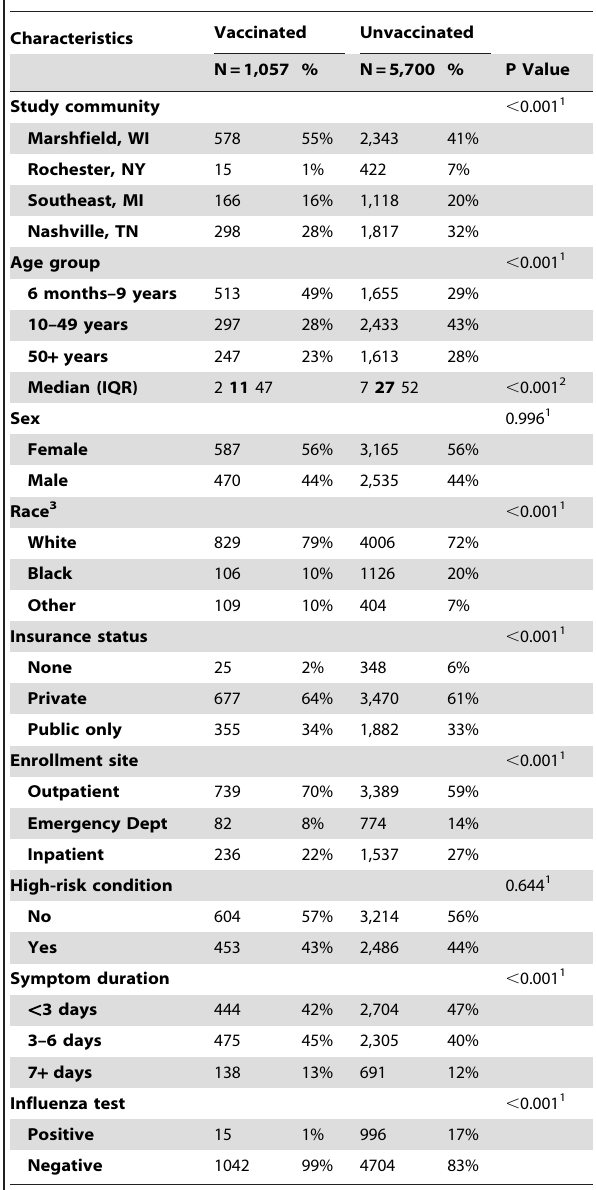
Table 2. Descriptive Characteristics of Enrolled Patients with Medically Attended Acute Respiratory Illness by Pandemic Vaccine